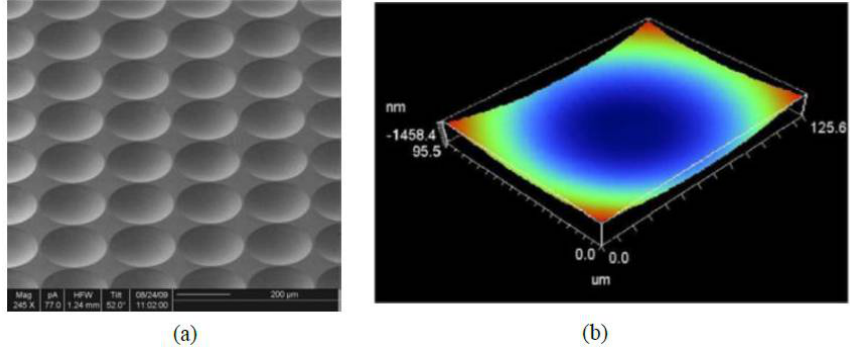
Figure 14. ( a ) SEM image of the replicated microlenses into the resist PAK-01; ( b ) surface profile of an imprinted microlens [42]. Copyright 2010 Elsevier.